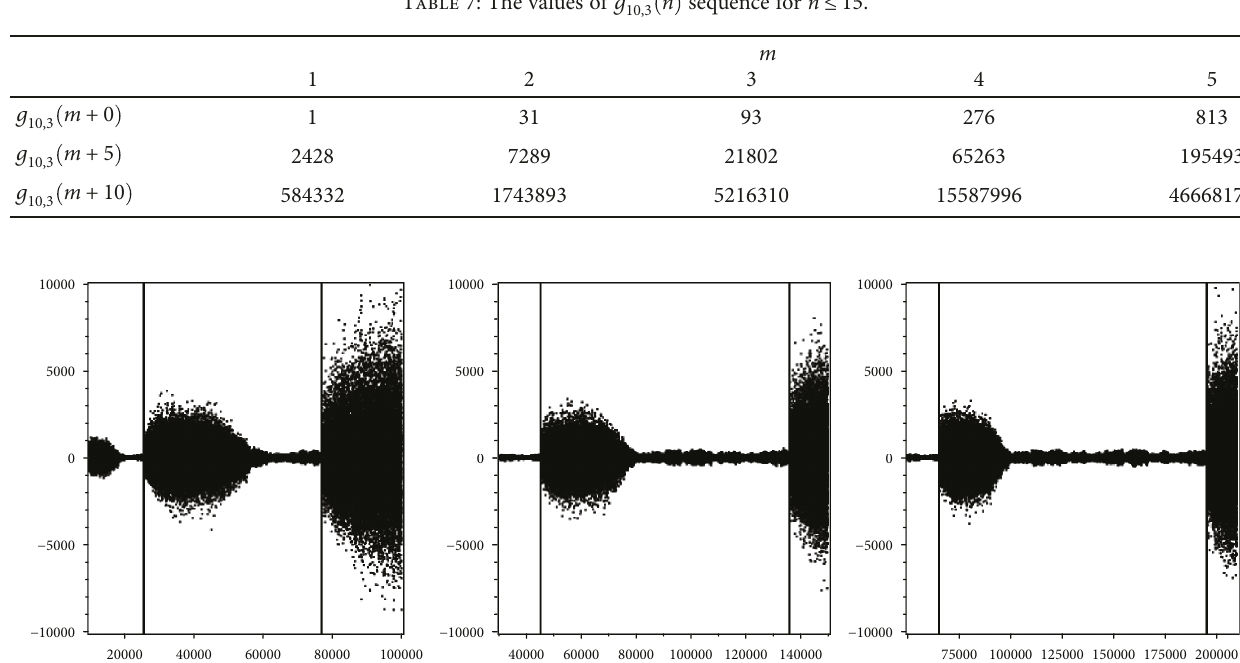
Table 7: The values of g